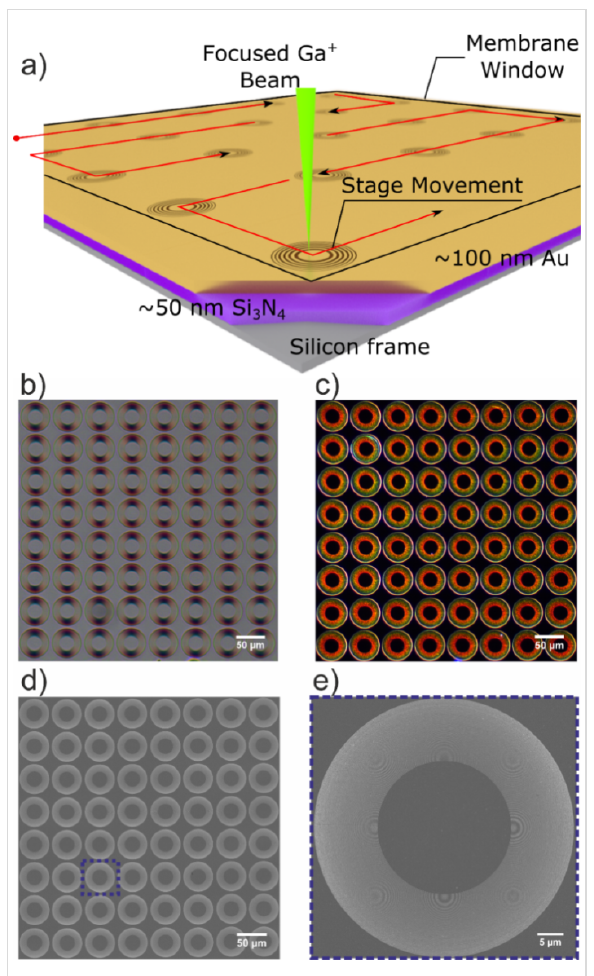
Figure 4: a) The fabrication scheme for an array of FZPs. The beam is scanned over the region of interest to write the FZP pattern, then, the stage moves to the new FZP position, and the process is repeated. b) Bright-field optical microscopy image of the array under polarized light. The familiar cross-shaped reflected light from the FZPs is an indi- cator of high quality. c) Dark-field optical image without the polarizer. The blue-shifted reflected intensity from inner zones to outer zones is attributed to shifting plasmon resonances of the zones made out of gold. d) A STEM-DF image of the fabricated 8 × 8 array of 64 FZPs. e) A STEM-DF image of FZP of row 6 and column 6.